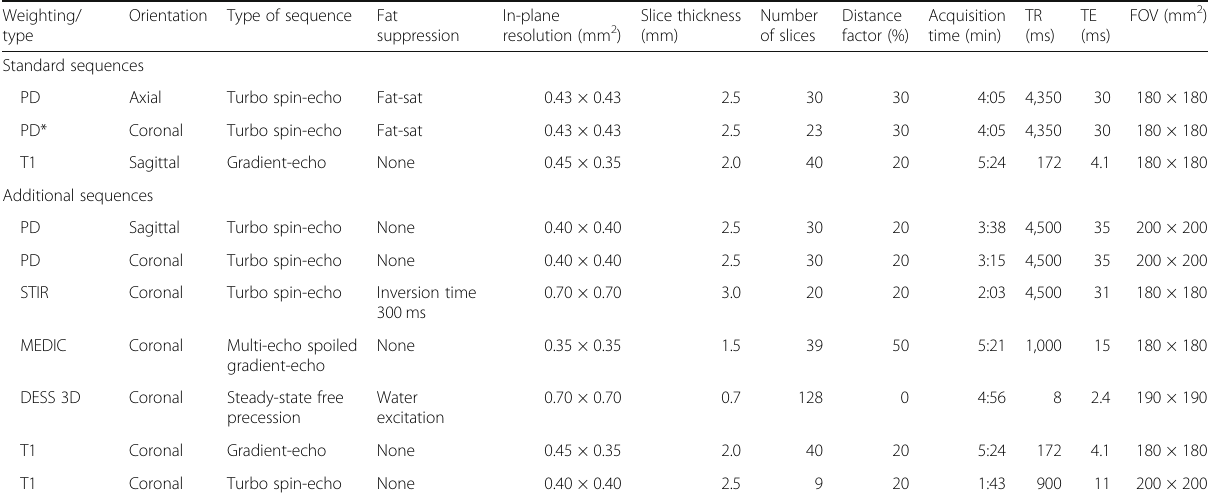
Table 1 Sequence parameters of the 7-T shoulder MRI protocol. Weighting/